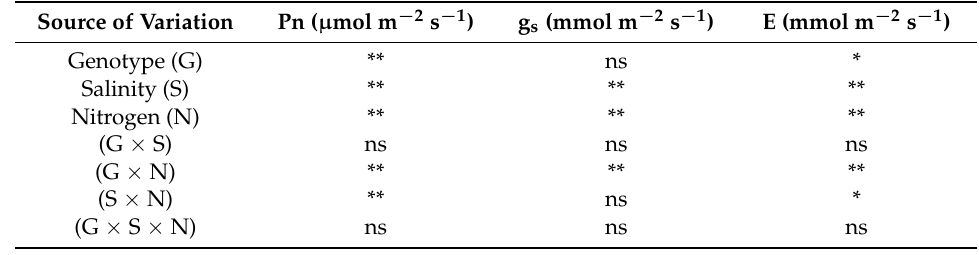
Table 2. Summary of analysis of variance for the photosynthetic rate (Pn), stomatal conductance (gs), and transpiration rate (E) at the flowering stage in the second run of a controlled greenhouse study.